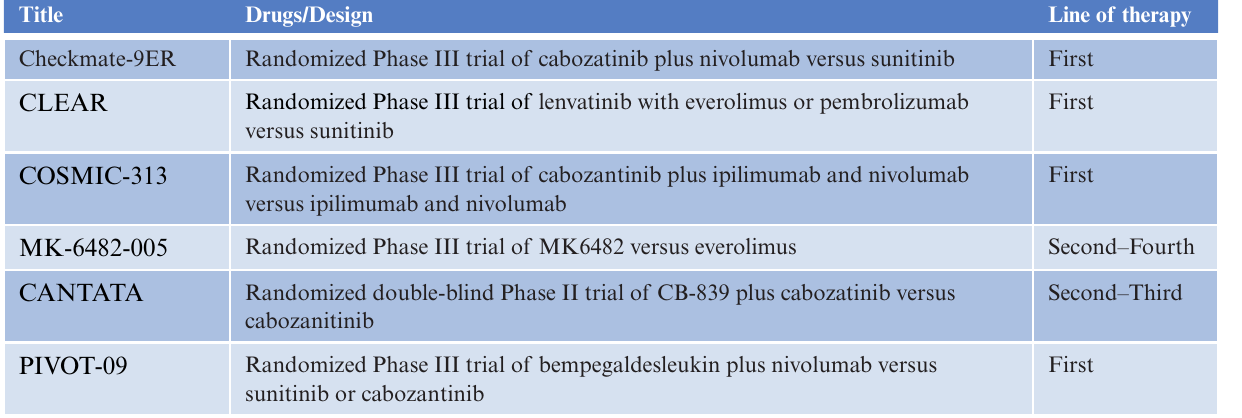
Table 2: Important ongoing clinical trials in patients with advanced